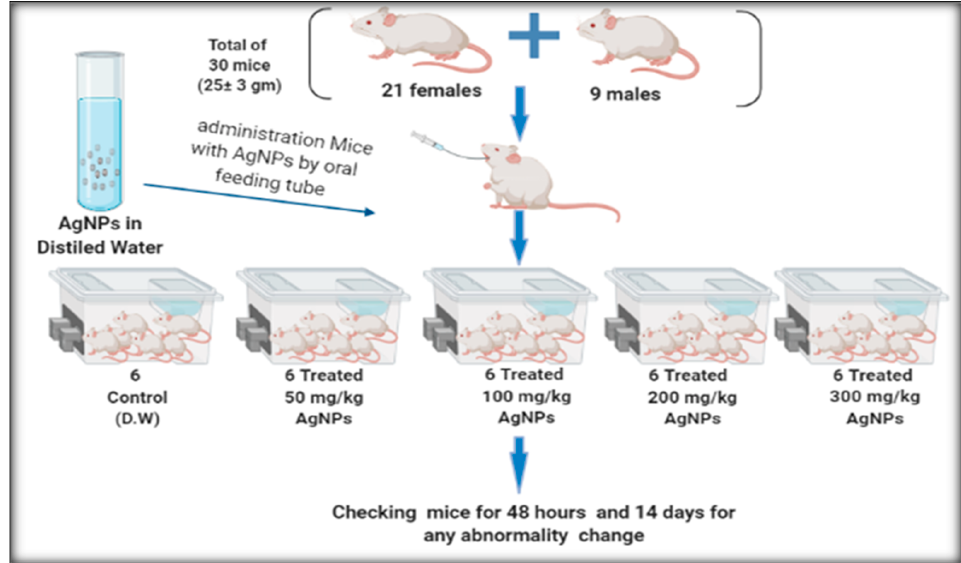
Figure 2. The in vivo toxic effect of AgNPs using 50 mg, 100 mg, 200 mg, and 300 mg/kg. Group 1: Control group which were orally administered with sterilized distilled water. Group 2: Experimental group which were orally administered with 50 mg/kg AgNPs diluted in distilled